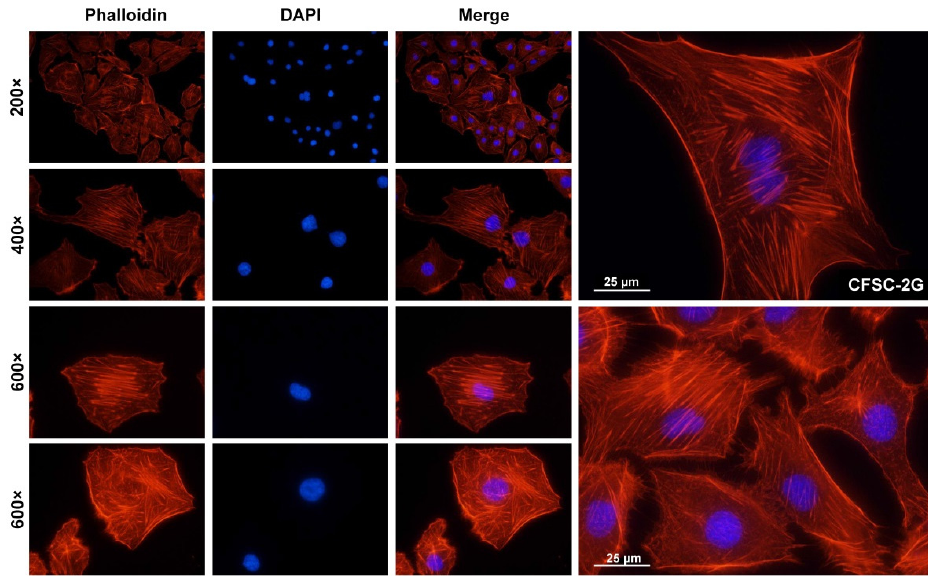
Figure 6. Cytoplasmic microfilaments in CFSC-2G. Cultured CFSC-2G cells were seeded on glass coverslips and stained with a Rhodamine–Phalloidin conjugate one day later. The prominent network of intracellular microfilaments points to a high activity in cytokinesis, movement, and cell motility. Nuclei were counterstained with 4 (cid:48) ,6-diamidino-2-phenylindole (DAPI) and pictures were taken under a fluorescence microscope at indicated